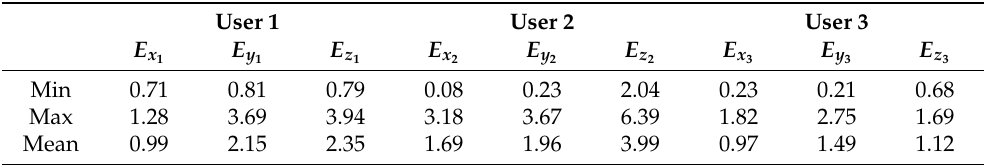
Table 1. Results of the assessment of the calibration accuracy. The values for each user are calculated from the six calibration points. All errors are in mm in { R } .